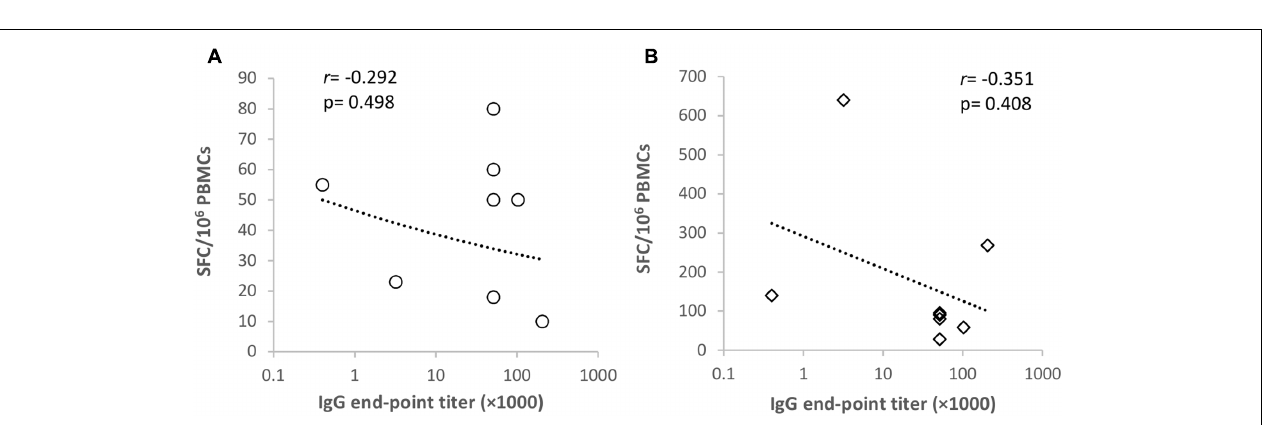
FIGURE 3 | Norovirus genotype-specific immunoglobulin G (IgG) antibody titers. The plasma of eight donors was used to determine individual end-point titer (A) and geometric mean titers (GMTs) with 95% confidence intervals (B) against NoV GII.4-1999, GII.4 Sydney, and GI.3 VLPs in an enzyme-linked immunosorbent assay (ELISA). Statistical significance was determined by Fisher’s exact test, and a p -value ≤ 0.05 was considered to be statistically significant ( ∗ ).